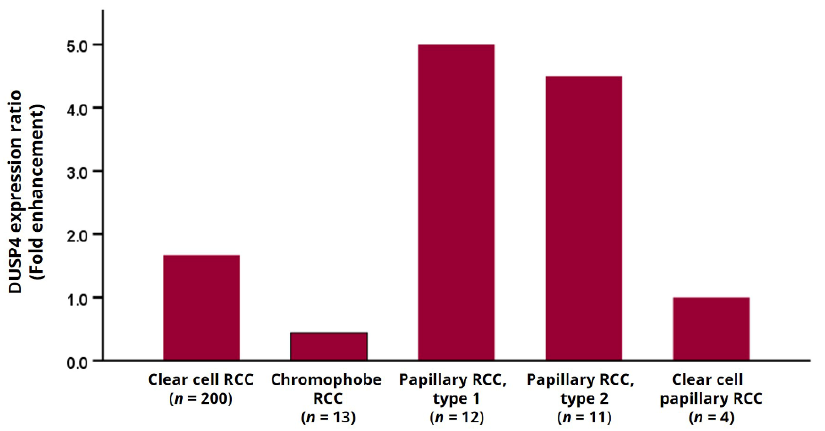
Figure 1. Representative photomicrographs of immunohistochemical staining for DUSP4 in clear cell RCC (( a ): negative, ( b ): positive, ×400). Nuclei of tumor cells clearly showing brown color were considered as positive staining (indicated by red arrows).